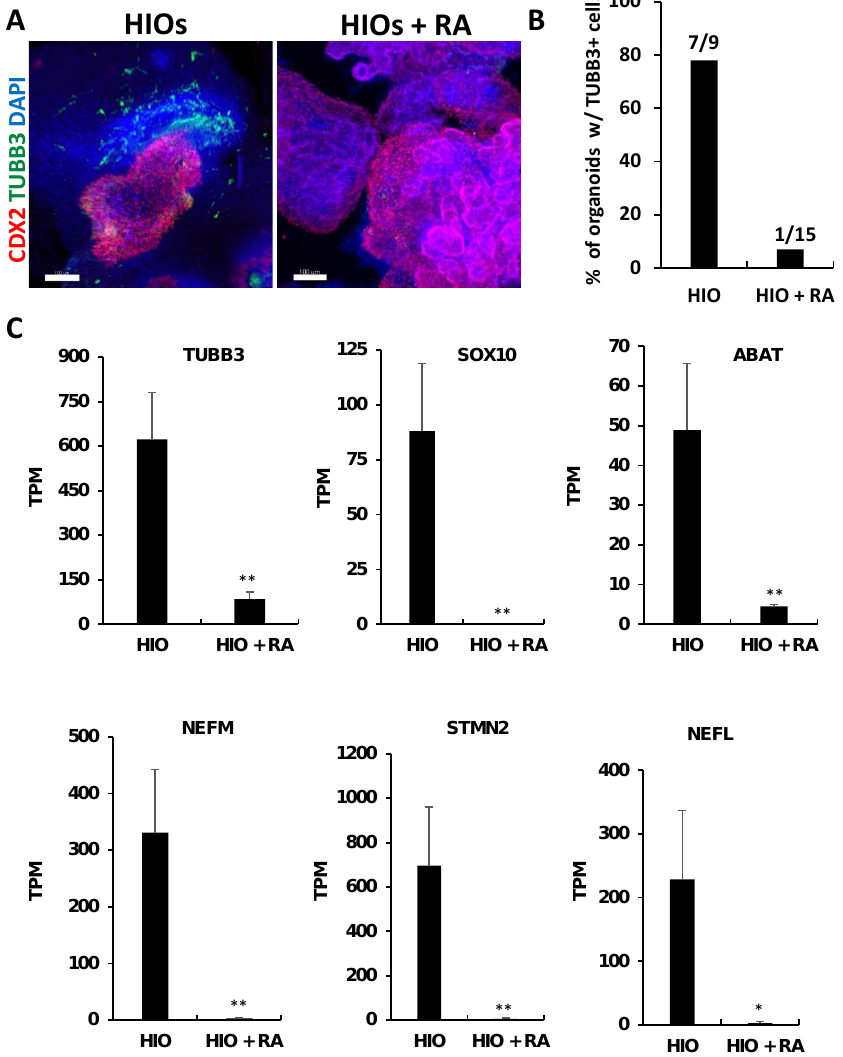
Figure 6. Retinoic acid inhibits the co-development of neurons in HIOs. ( A ) Whole-mount im- munofluorescence staining of 35-day-old organoids from (HIOs and HIOs + RA) for CDX2(red), TUBB3 (green) and counterstained with DAPI. ( B ) The quantification of the percentage of